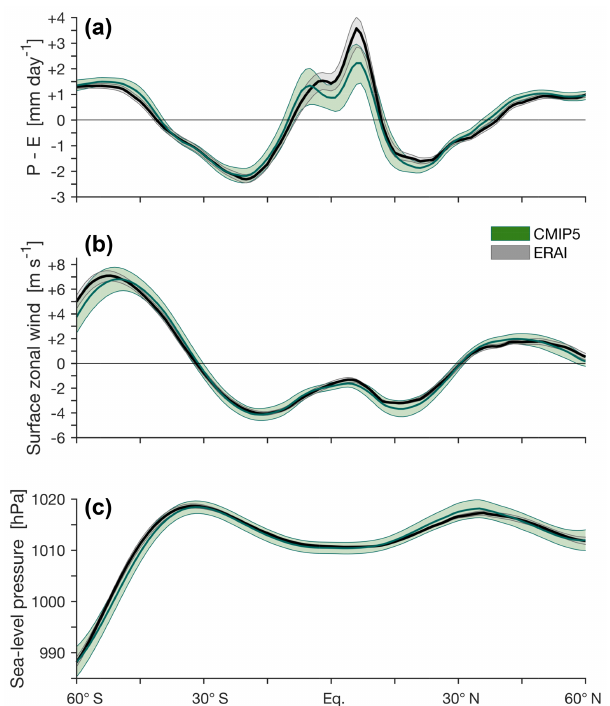
Figure 7. Zonally averaged annual-mean values of (a) precipitation minus evaporation ( P − E ), (b) surface zonal wind, and (c) sea-level pressure in CMIP5 models (green) and ERAI (black) for 1979– 2004. The shading indicates ± 1 standard deviation of inter-model spread for CMIP5 models and of interannual variations for